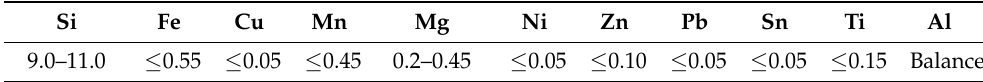
Table 1. Chemical composition of AlSi10Mg powder (wt.%).